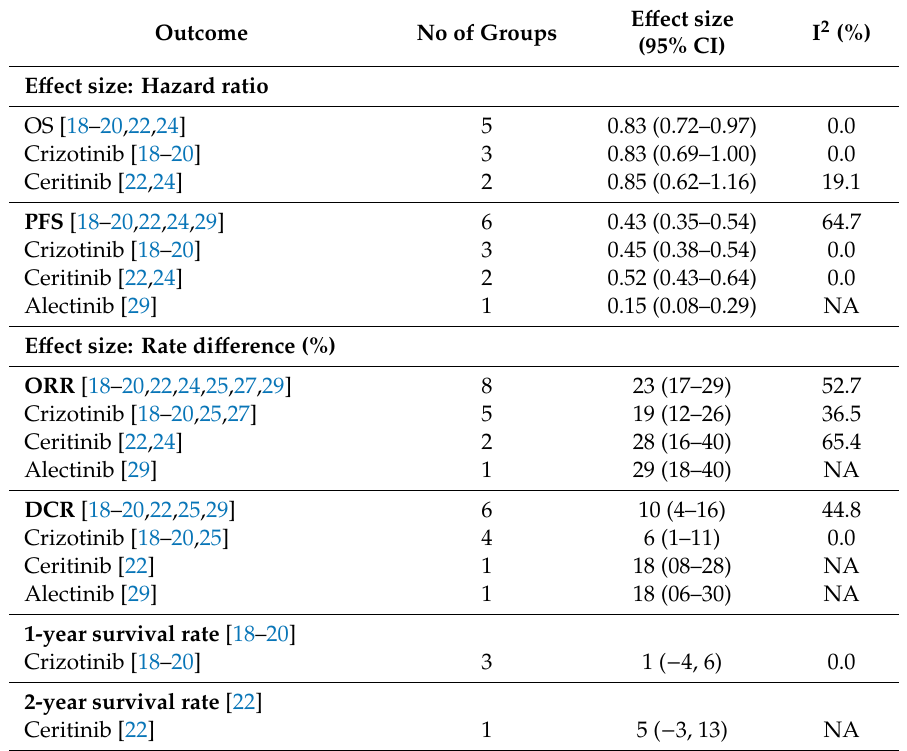
Table 4. E ffi cacy of ALK inhibitors compared with chemotherapy in patients with ALK-positive non-small cell lung cancer by type of ALK inhibitors for each outcome. Outcome No of Groups